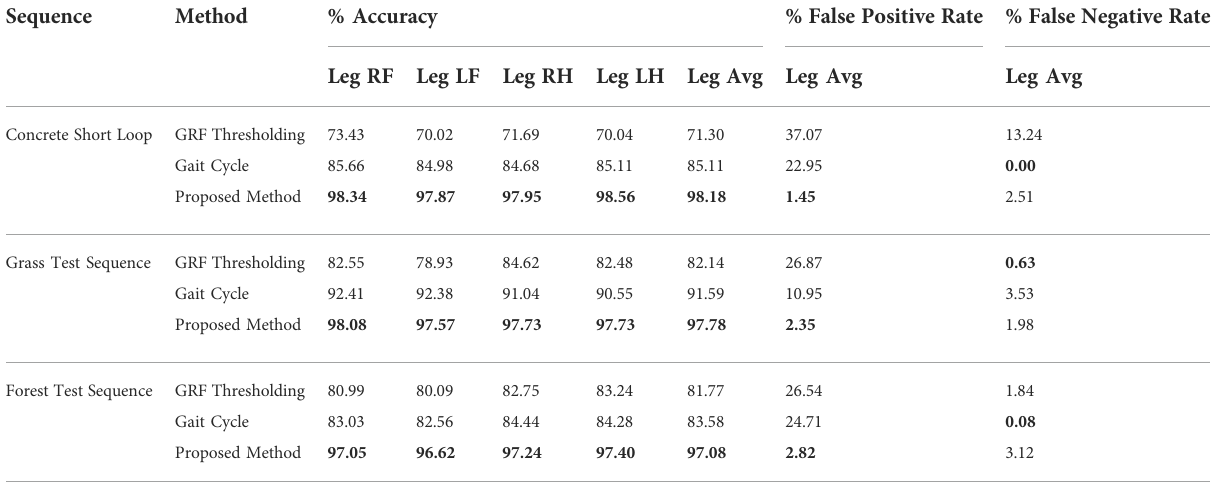
Bold values in tables show the best